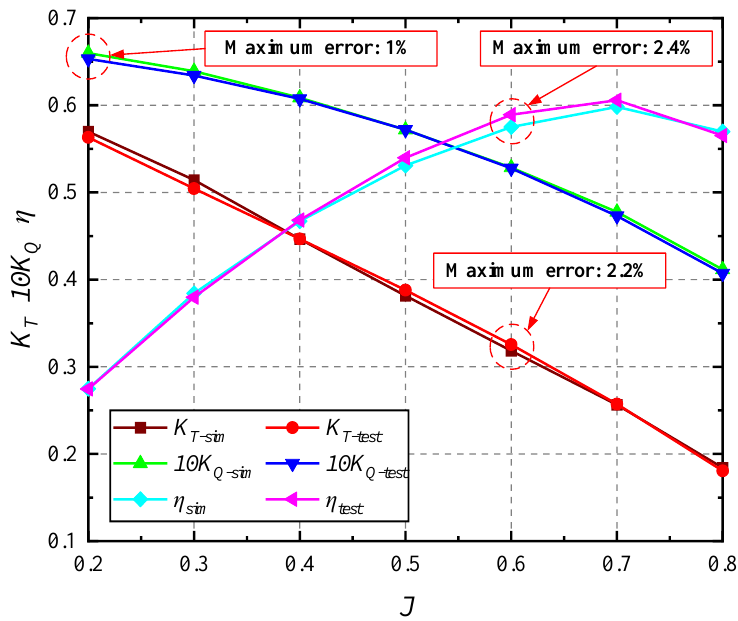
Figure 5. Comparison of the simulation and test results of the duct propeller.